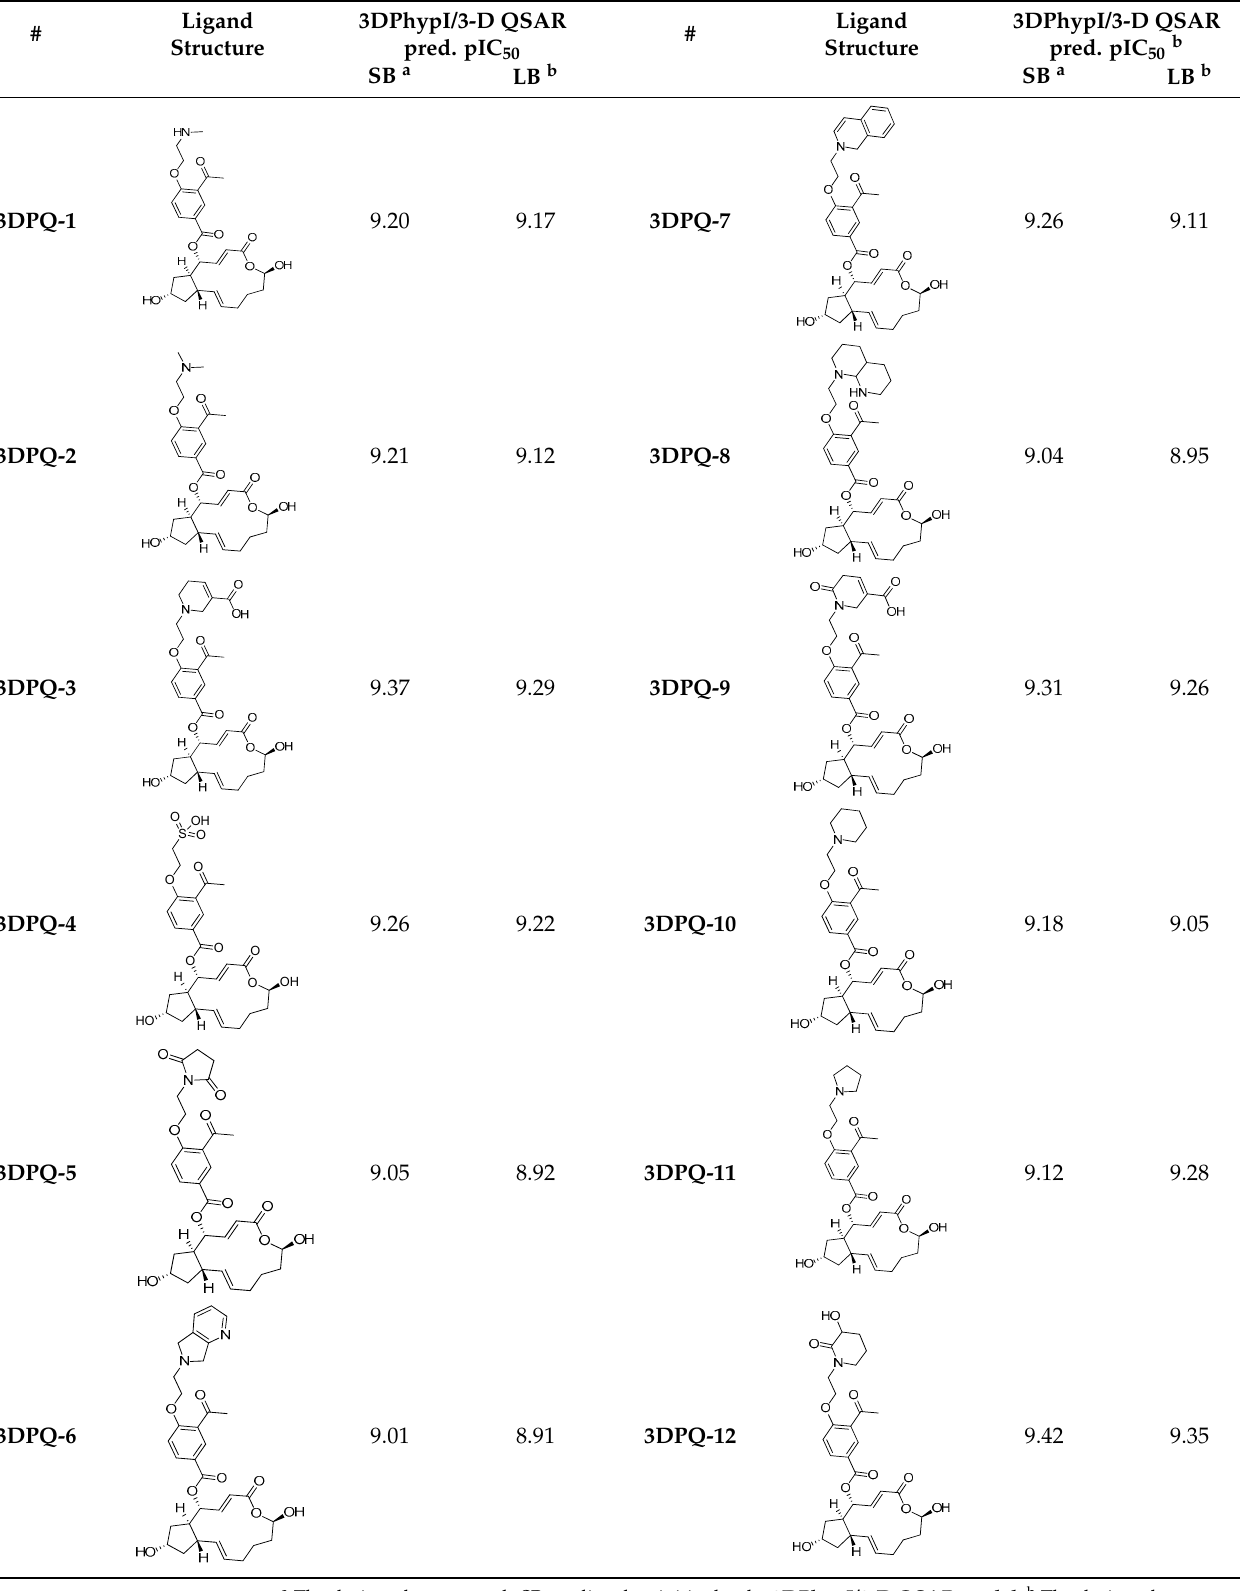
Table 6. Structures of designed hits and their predicted activities against ER α .